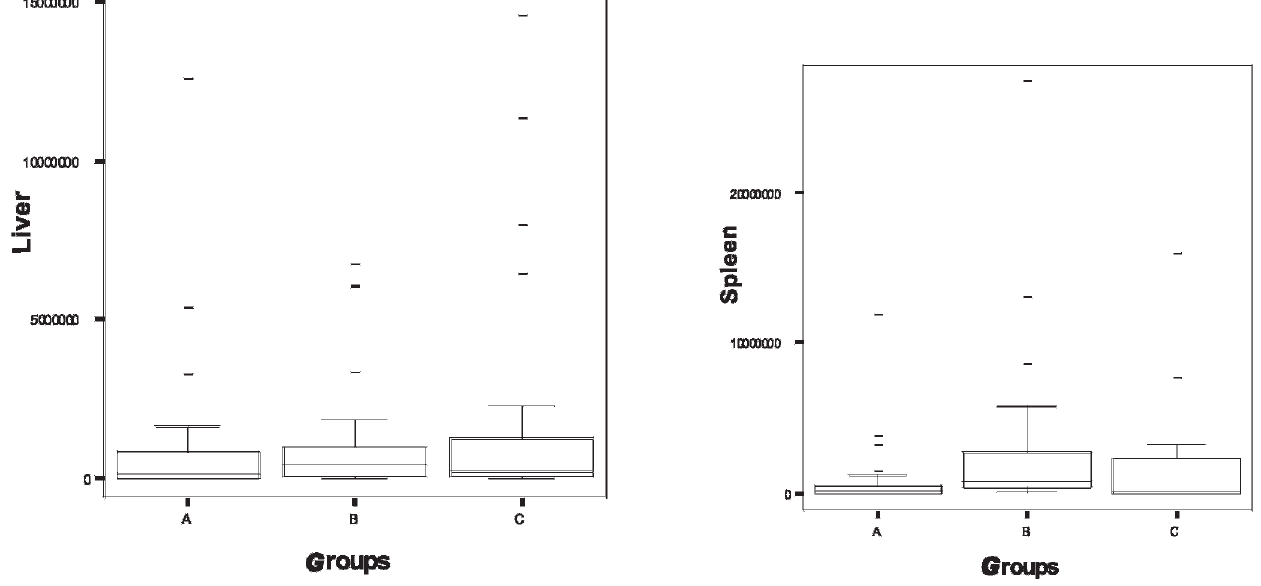
Figure 2 - Box-plots for liver and spleen tissue cultures. Groups: A = no pneumoperitoneum, B = pneumoperitoneum, and C = pneumoperitoneum + mechanical ventilation.